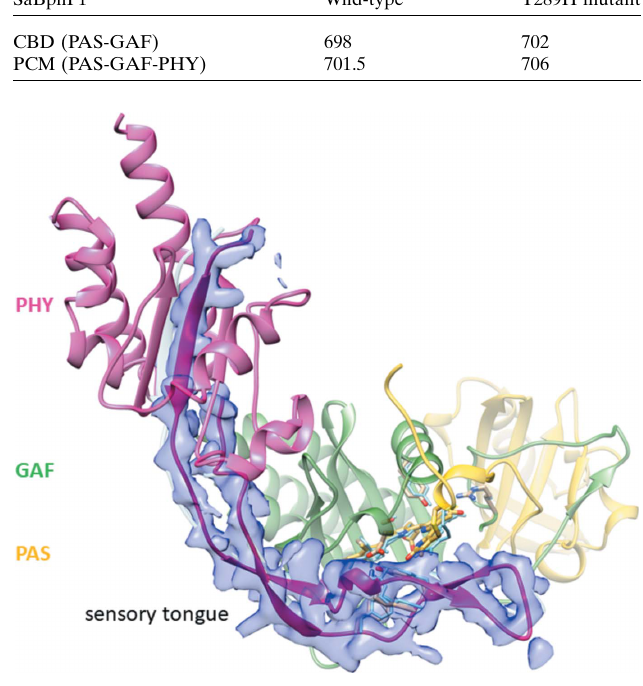
Figure 12 The sensory tongue in the SaBphP1-PCM wild-type and Thr289His mutant. The region from residue 435 to 490 in the PCM of the T289H mutant, subunit B , is displayed in transparent blue (2 mF o (cid:5) DF c electron density at the 1.1 (cid:7) contour level). The PAS, GAF and PHY domains are colored yellow, green and magenta, respectively.